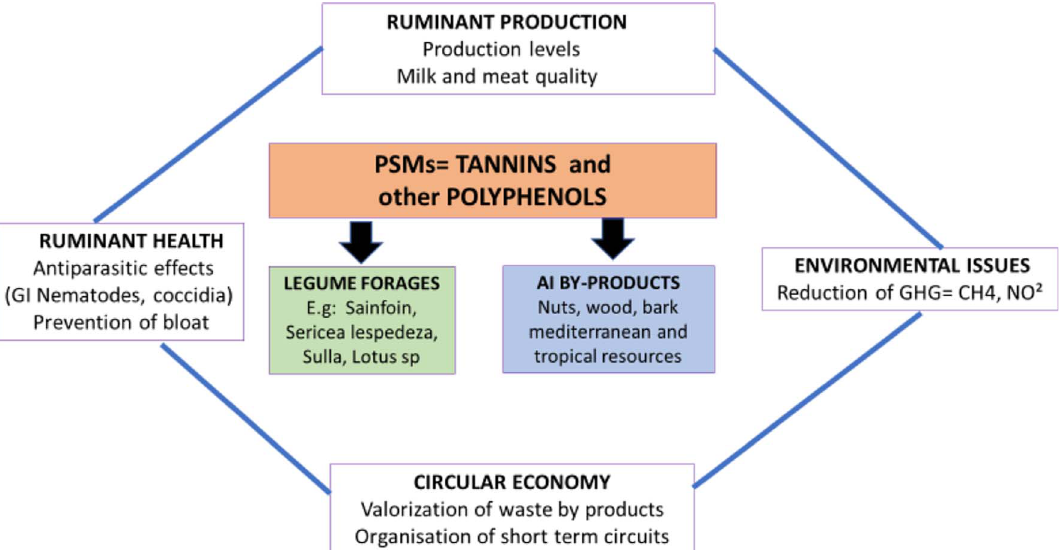
Figure 2. A summarised diagram of the various potential bene fi ts of tannin-containing forages (e.g. sainfoin or sericea lespedeza) and/or by- products in ruminant production in the context of agro-ecological production. Examples and results by referring to the general framework and objectives presented in Figure